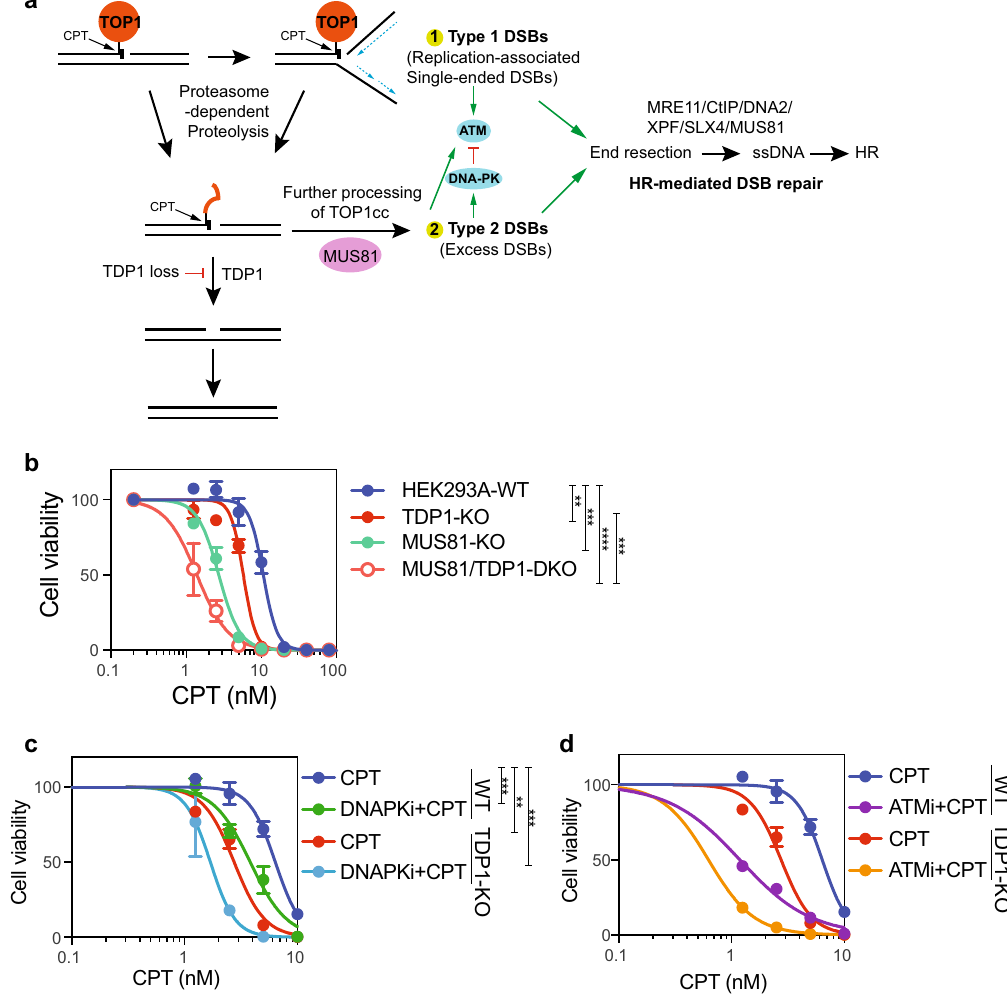
Fig. 8 Co-inhibition of TDP1 and DSB repair pathway enhanced cellular sensitivity to CPT treatment. a Working model of TOP1-induced damage repair in WT and TDP1-KO cells. b The proliferation of HEK293A-WT, TDP1-KO, MUS81-KO, and MUS81/TDP1-DKO cells was measured using a CellTiter-Glo assay after 3 days in the presence of the indicated concentrations of CPT. Data are presented as the mean±SD ( n = 3 biologically independent experiments). A two- tailed unpaired t -test was used for statistical analysis of the IC50 of each cell line. ** p (HEK293A-WT vs. TDP1-KO) = 0.005347, *** p (HEK293A-WT vs. MUS81-KO) = 0.000216, **** p (HEK293A-WT vs. MUS81/TDP1-DKO) = 0.000024, and *** p (TDP1-KO vs. MUS81-KO) = 0.000442. c The proliferation of HEK293A-WT and TDP1-KO cells was measured using a CellTiter-Glo assay after 7 days in the presence of the indicated concentrations of CPT and DNAPKi (AZD7648) + CPT. Data are presented as the mean±SD ( n = 3 biologically independent experiments). A two-tailed unpaired t -test was used for statistical analysis of the IC50 of each cell line. *** p (WT_CPT vs. WT_DNAPKi + CPT) = 0.000276, ** p (WT_CPT vs. TDP1-KO_CPT) = 0.001041, and *** p (WT_CPT vs. TDP1-KO_DNAPKi + CPT) = 0.000685. d The proliferation of HEK293A-WT and TDP1-KO cells was measured using a CellTiter-Glo assay after 7 days in the presence of the indicated concentrations of CPT and ATMi (KU55933) + CPT. Data are presented as the mean±SD ( n = 3 biologically independent experiments). A two-tailed unpaired t -test was used for statistical analysis of the IC50 of each cell line. ** p (WT_CPT vs. WT_ATMi + CPT) =